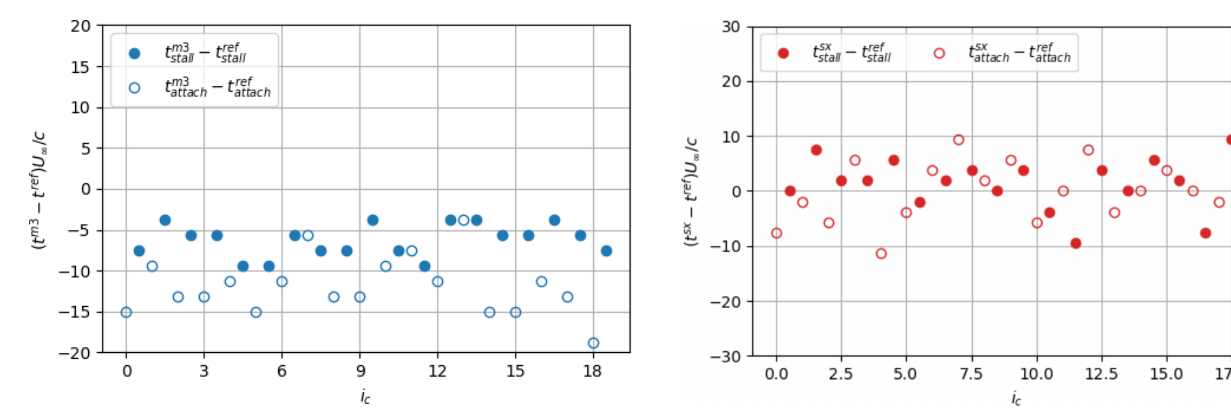
Figure 22. Results of the zero-crossing method to extract the flow stall–reattachment instants using the strip position. The filled circle ( i c ), and void circle sym- symbols correspond to stall instants, t sx stall bols correspond to reattachment instants, t sx ( i c ). attach